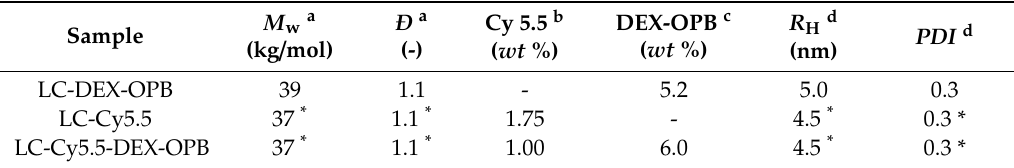
Table 2. Characteristics of polymer conjugates.